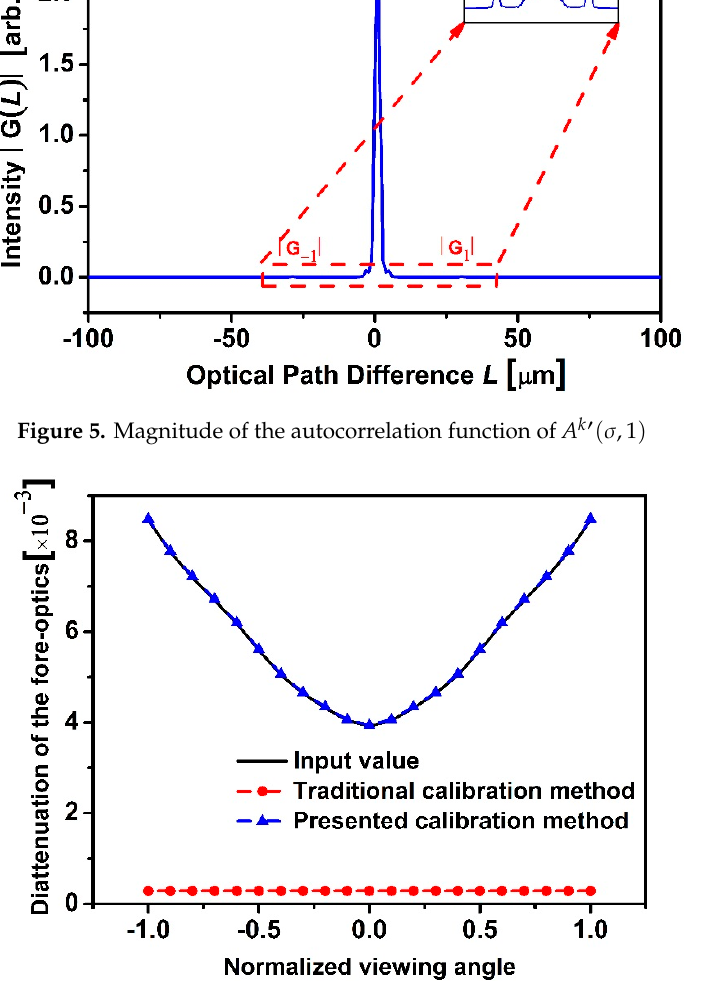
Figure 6. Input values and calibration results of the diattenuation of the fore-optics.